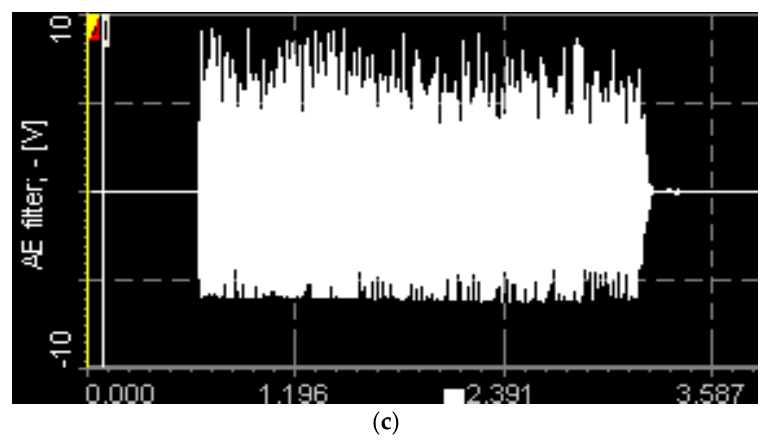
Figure 8. Time domain AE Out (Filter) signals recorded at cutting condition of 9000 rpm, 0.2 mm/rev, 0.5 mm doc (during 15th pass) using ( a ) Tool T1; ( b ) Tool T2; ( c ) Tool T3.